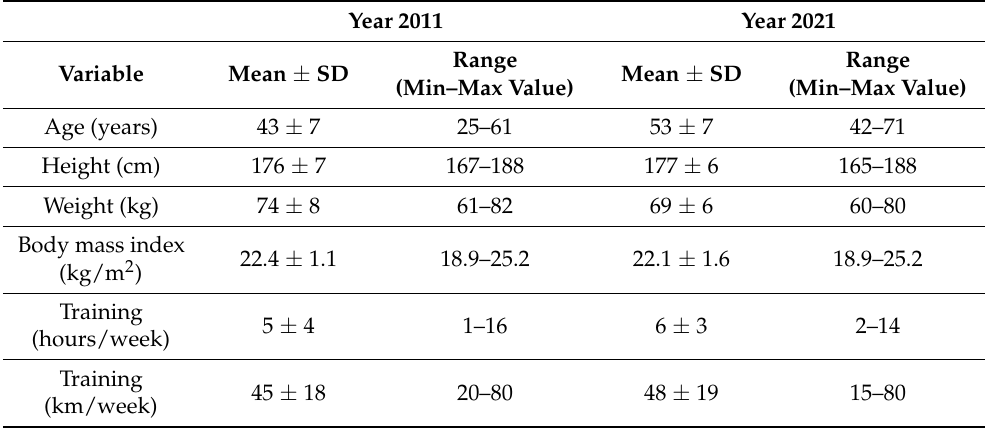
Table 1. Characteristics of the 46 amateur participants. Data are expressed as mean ± standard deviation (SD) and range (min–max value).